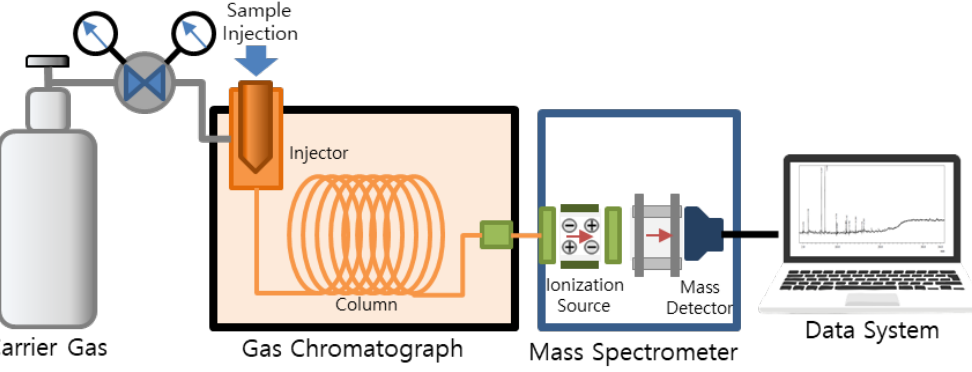
Figure 2. Gas Chromatograph / Mass Spectrometer (GC/MS) for VOCs analysis.